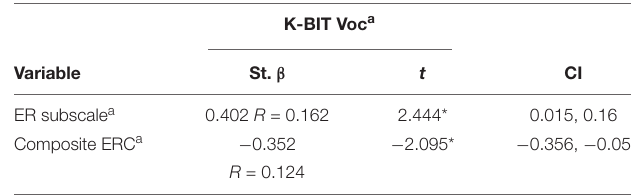
TABLE 4 | Regression model: influences of expressed and receptive vocabulary at wave 1 on emotional regulation in children at wave 2 (Study